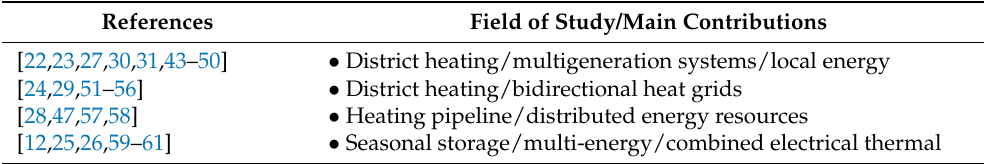
Table 2. Main publications and their contributions per year to thermal